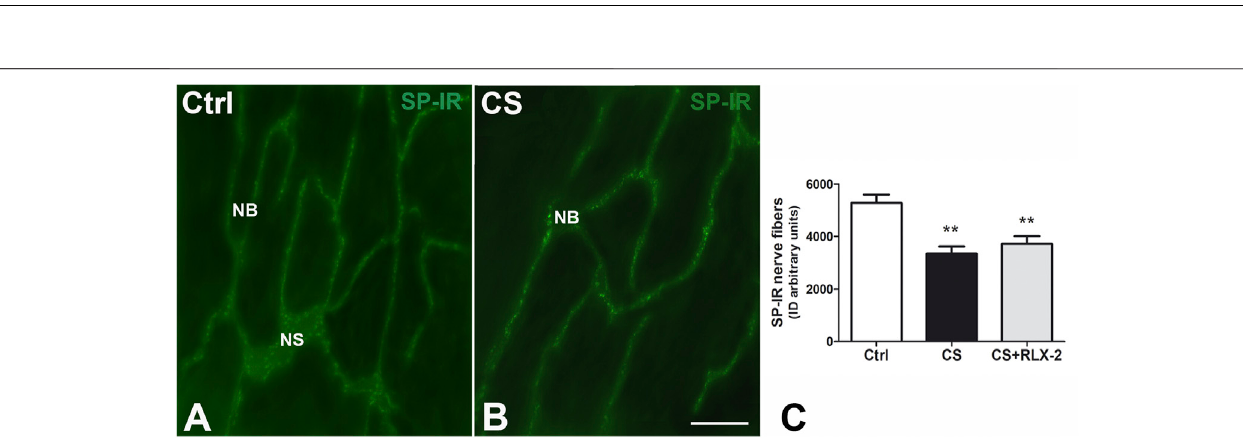
Frontiers in Pharmacology |